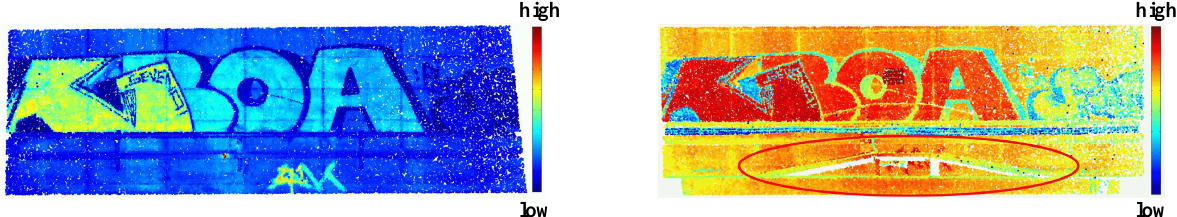
Figure 4: Relative intensities. Left. Epoch 1. Right Epoch 3. The location of the footbridge is indicated by a red ellipse.